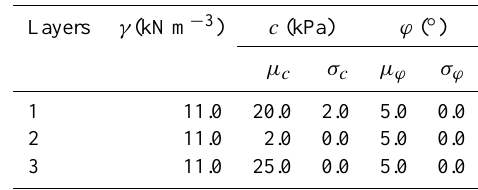
Table 11. Mean values and standard deviations for soil property parameters (soil number from top to bottom).